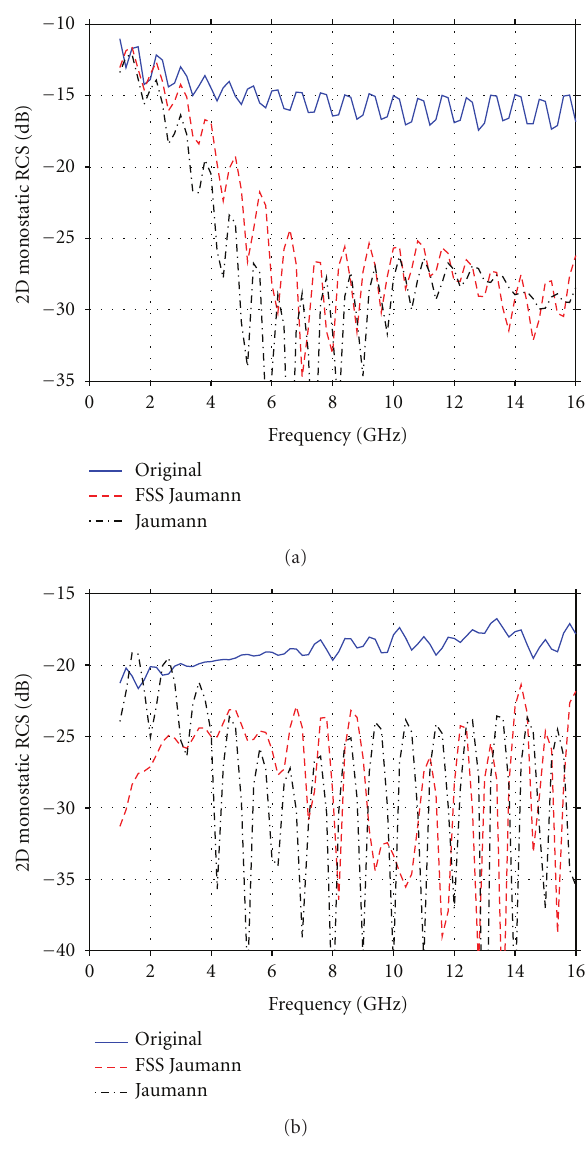
Figure 6: Monostatic RCS for normal-incident waves of the metal- front end of the wing (solid curve), Jaumann absorber front end of the wing (dashed-dotted curve), and FSS-backed Jaumann absorber front end of the wing (dashed curve). (a) shows the TM z polarization, and (b) shows the TE z